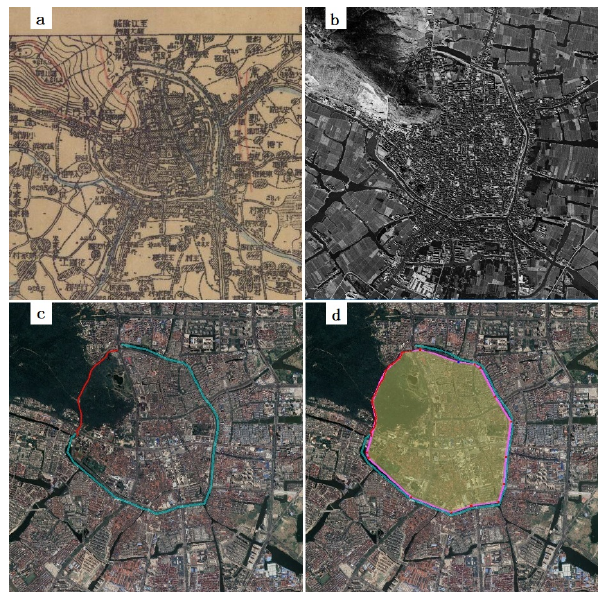
Figure 3. Maps and remote sensing images that show the city wall and associated relics of Changshu, Jiangsu Province. (a) The 1:50000 military topographic map made in 1928. The jagged line on the map represents the city wall, and the double line represents the river. (b) The 1970s CORONA photograph from USGS. (c) The remaining city walls (tagged as red line) and moats (tagged as blue line) are still clearly visible. The map is based on © Google Earth image, 2018. (d) According to the remains of the city walls and the moat, the extent of the city wall is drawn (yellow area). The map is based on © Google Earth image,